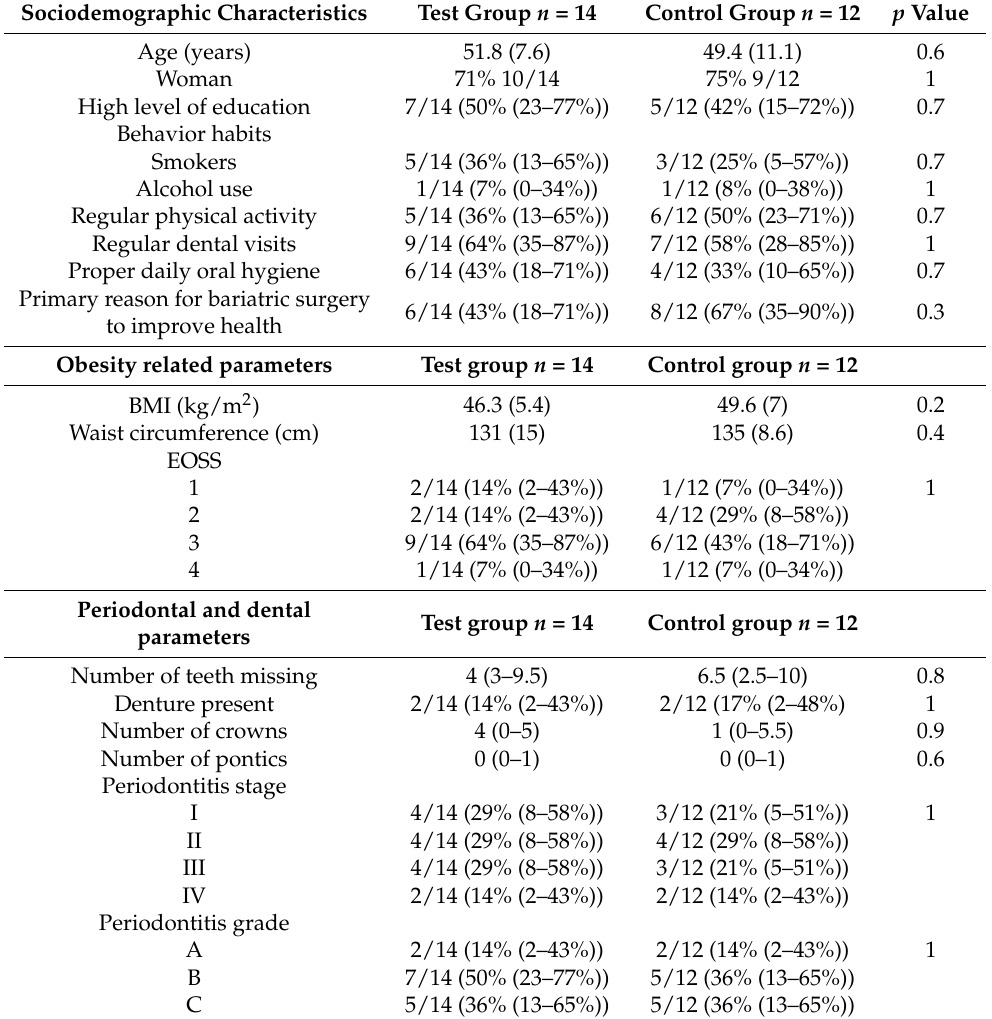
Table 1. Baseline characteristics of the patients in the test and control groups.